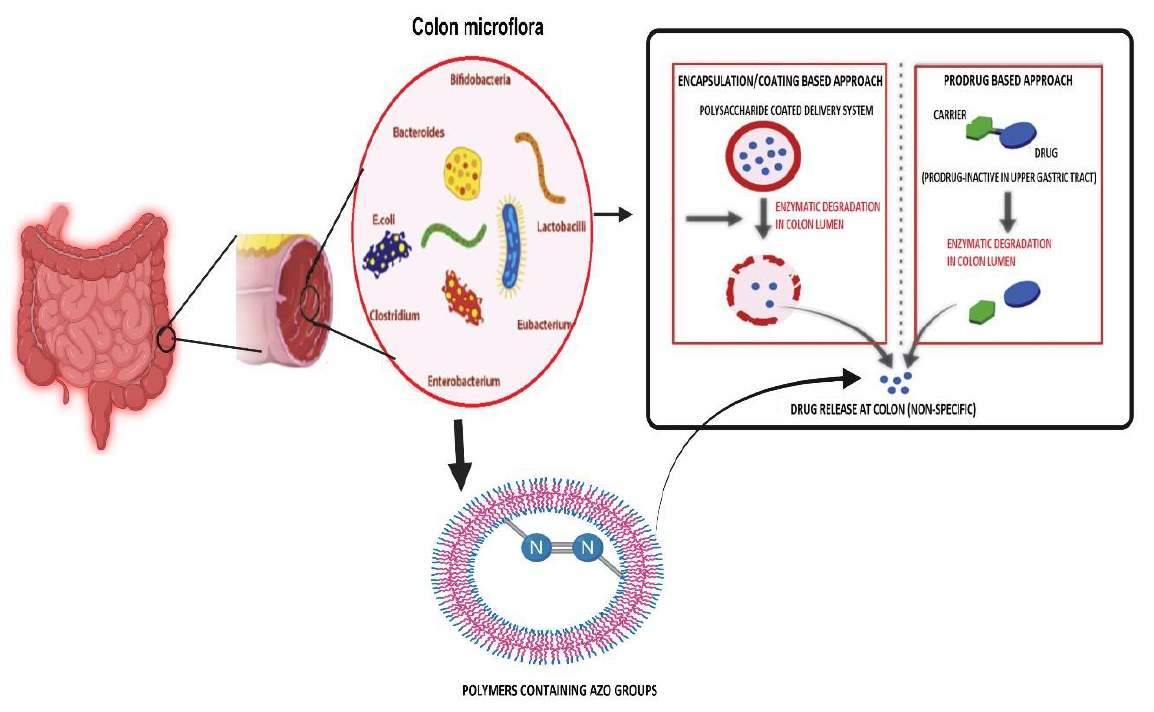
Figure 1. Illustrating various microbial metabolized approaches for colon target drug delivery systems. The pharmaceutical strategies that are commonly used to achieve a colon-specific drug delivery include time, pH-dependent polymer coating, prodrug, and the colonic microbiota azo group containing polymer-activated delivery systems, as well as a combination of these approaches. Image made by BioRender.